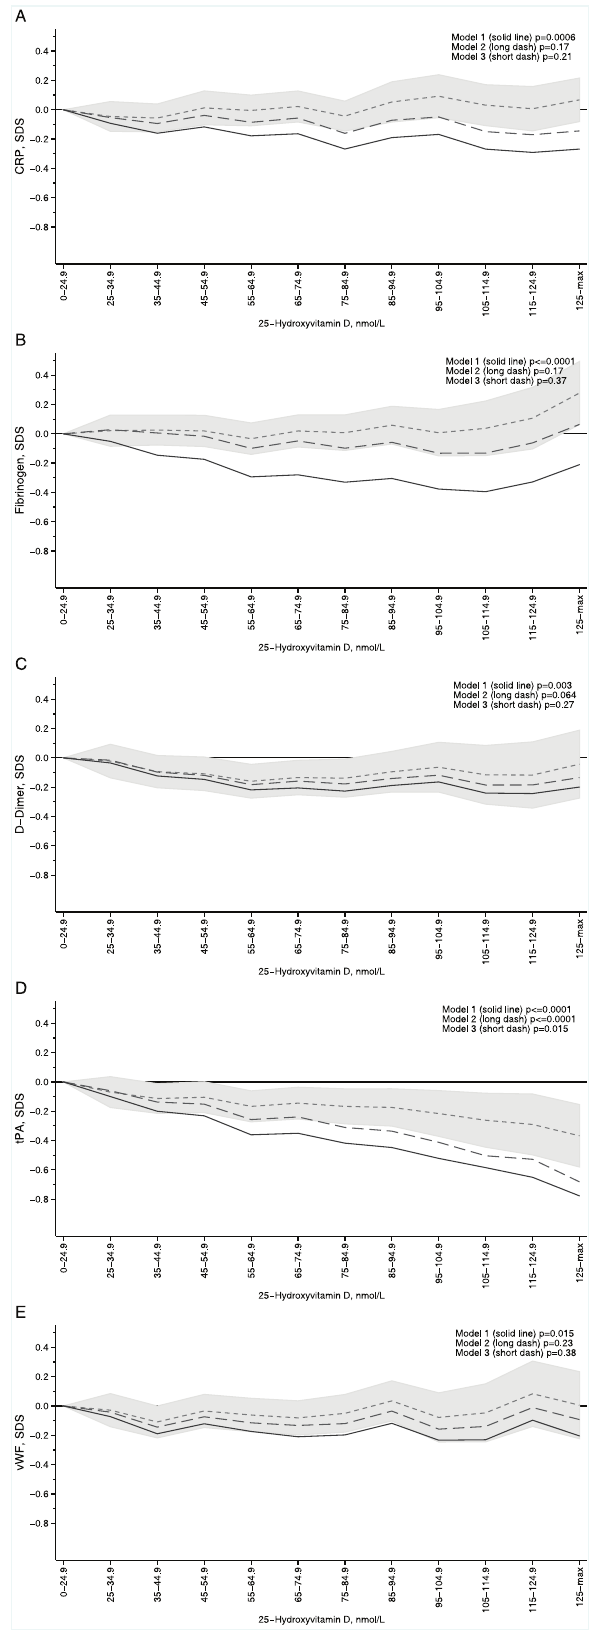
Figure 2. Variation in C-reactive protein (A), fibrinogen (B), D- dimer (C), tissue plasminogen activator (D), and von Will- ebrand factor (E) by 25(OH)D concentration. Model 1 (solid line): adjusted for month of measurement and sex. Model 2 (dashed, short): adjusted for lifestyle and social indicators (physical activity, time spent watching TV/using PC, smoking, alcohol consumption and birth and adult social class), month of measurement and sex. Model 3 (dashed, long): adjusted for adiposity (BMI and waist circumference), lifestyle/ social indicators, month of measurement, and sex. Values are coefficients from linear regression (reference , 25nmol/l), 95% confi- dence intervals presented for Model 3 by the shaded area.